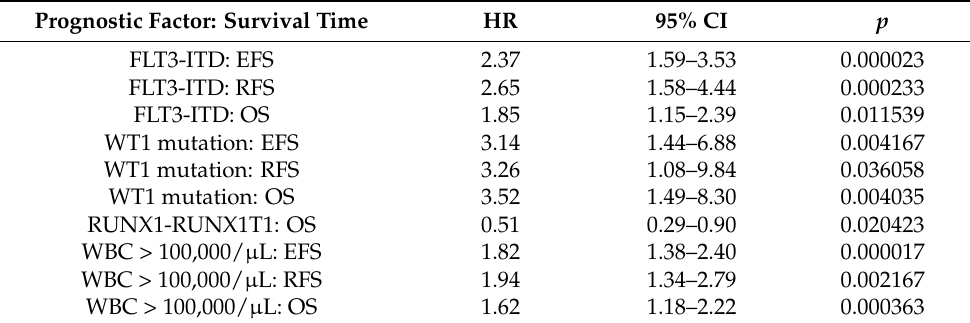
Table 7. Prognostic factors: Cox regression univariate analysis (significant results).